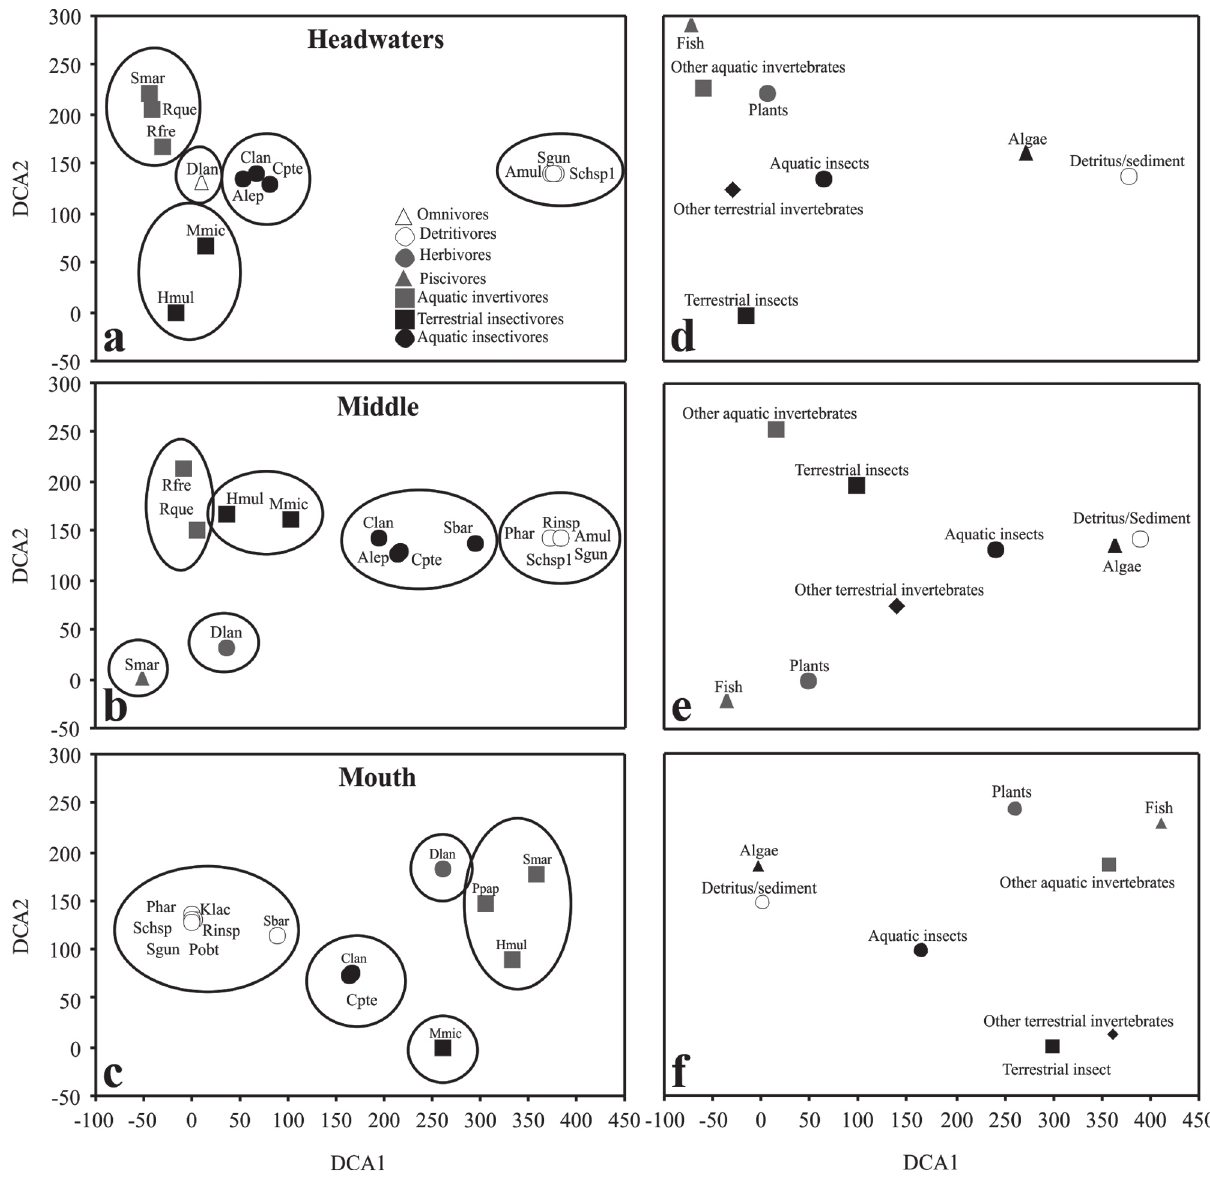
Fig. 3. Ordination of fish species in the respective trophic guilds ( a , b, c ) and food items ( d, e, f ) along the longitudinal gradient of the Vermelho River, East Atlantic basin, Antonina, Paraná State, Brazil. Circles represent species belonging to the same trophic guild. Codes according to Table